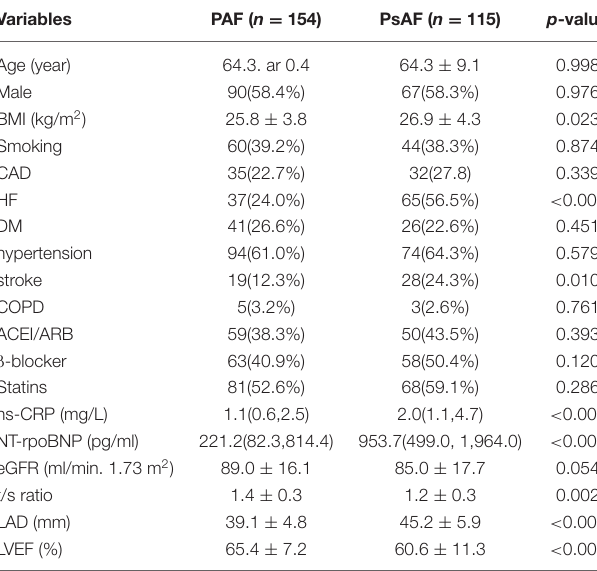
TABLE 2 | Baseline characteristics by AF progression.